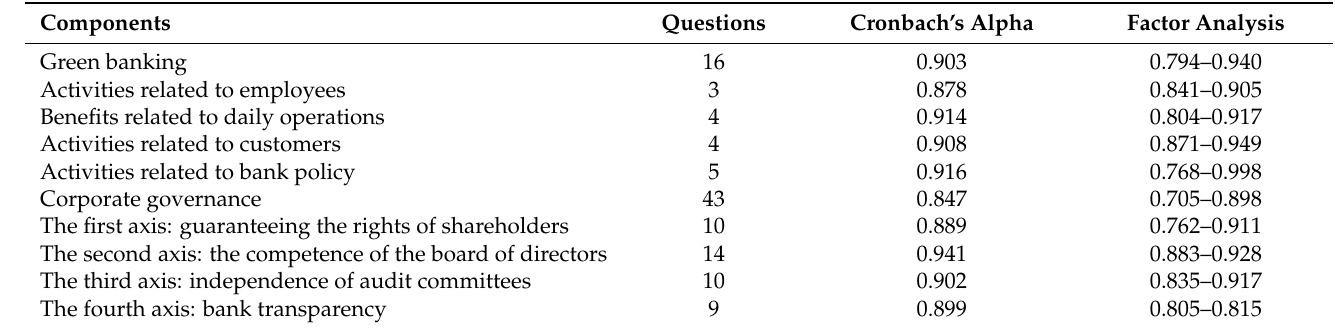
Table 6. The components, number of questions, Cronbach’s alpha, and factor analysis results.